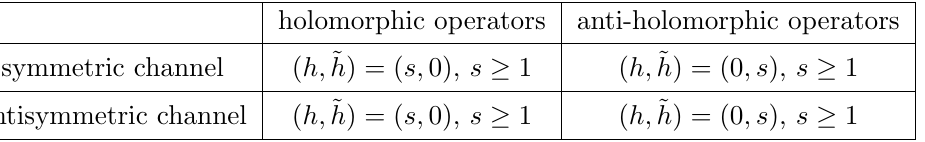
Table 1. The conserved operators in the limit